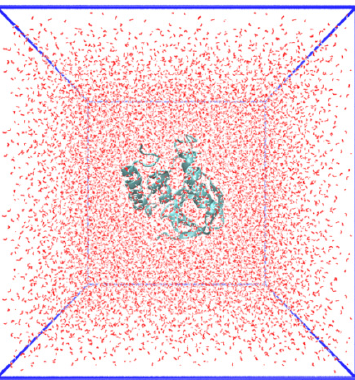
Figure 10. Simulation system protein centered in the 7nm × 7nm × 7 nm box.